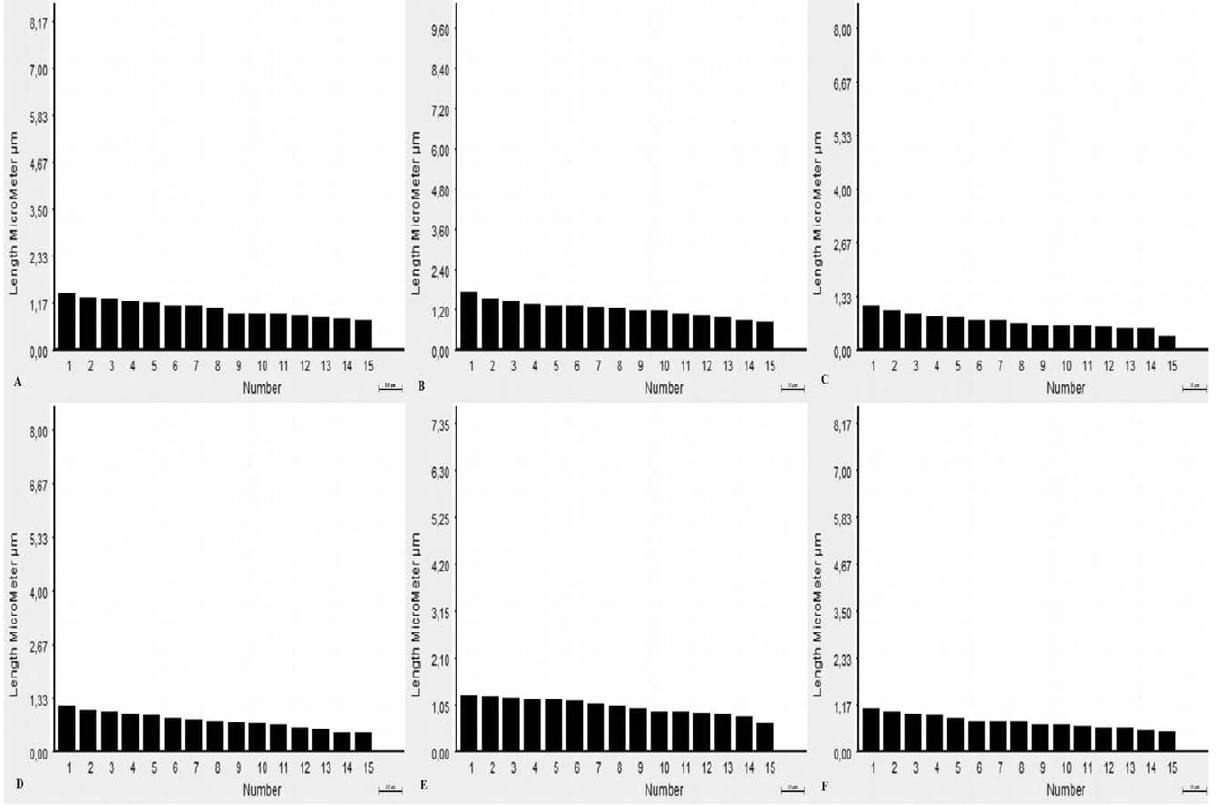
Figure 4A-F. Ideograms of hybrids and their parents: A) O. × adae (TD4518); B) O. ayliniae (TD4516); C) O. sipyleum (TD4517); D) O. × intermedium (TD4726 ); E) O. onites (TD4725); F) O. sipyleum (TD4727). Scale bar: 10